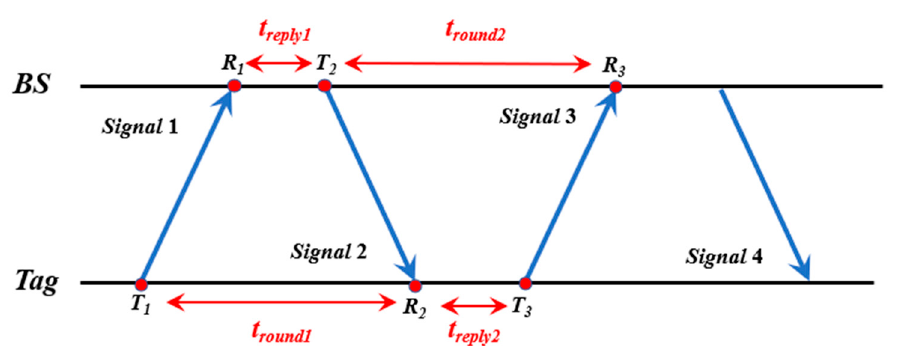
Figure 8. TDOA positioning principle.